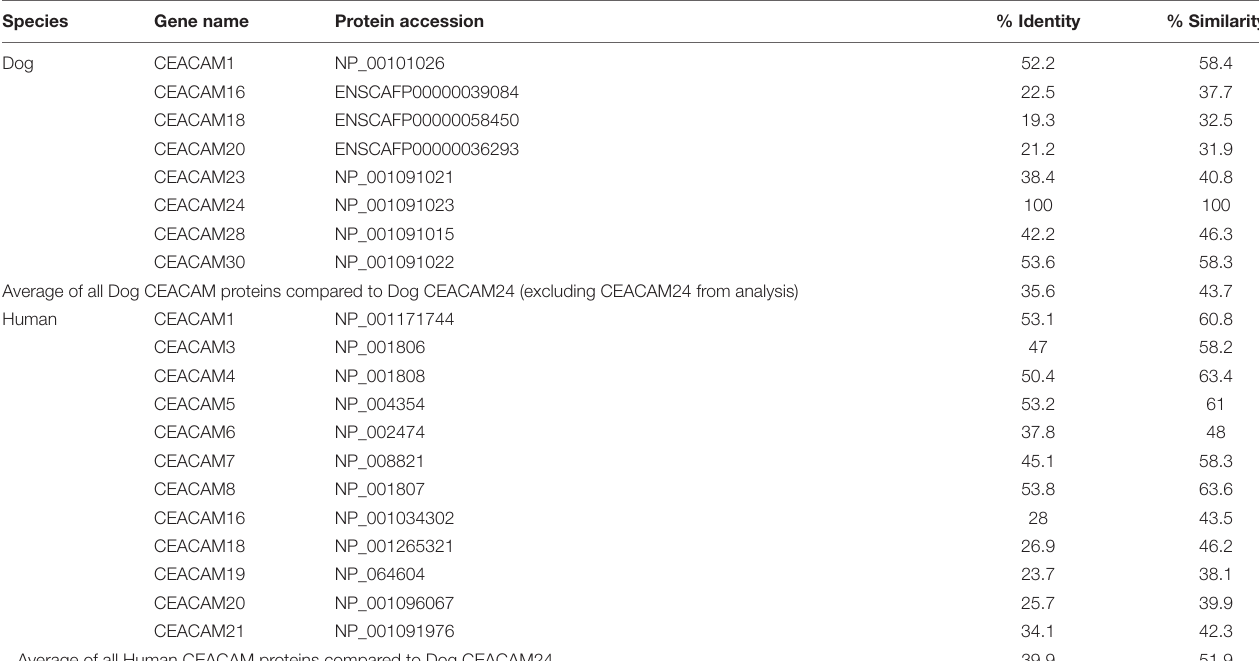
TABLE 2 | Homology of dog and human ceacam proteins to dog CEACAM24